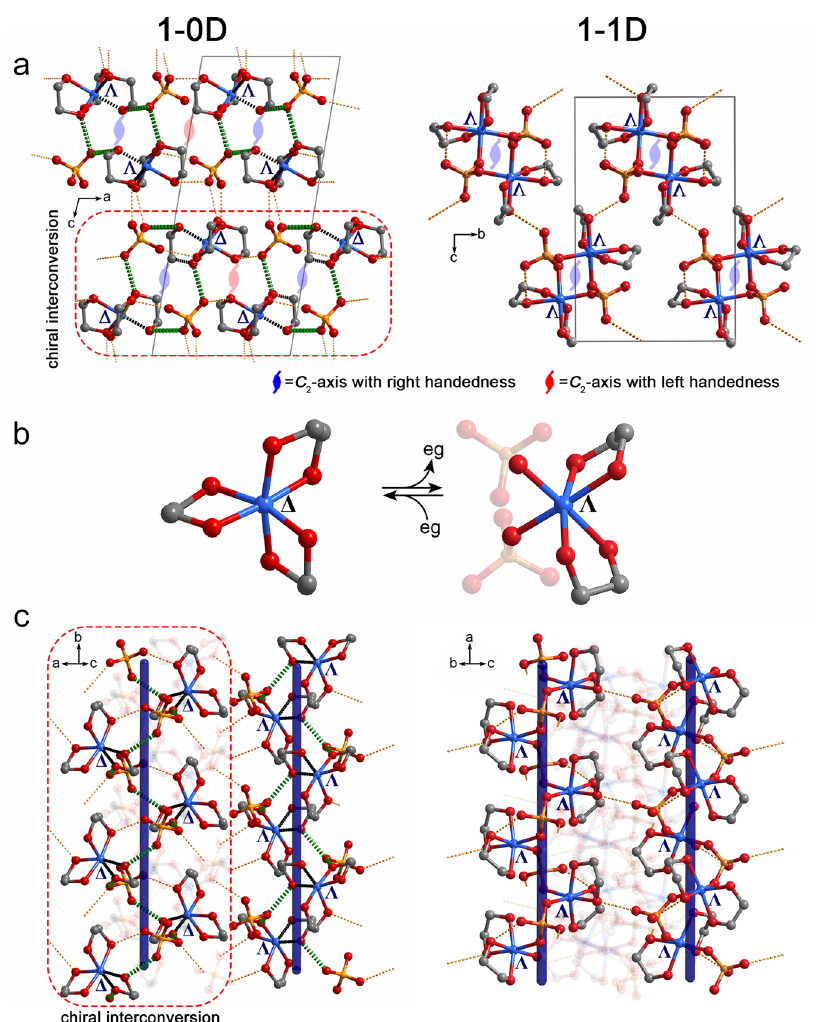
Fig. 4 Proposed mechanism for the SCSC transformation from 1-0D to 1-1D. a Contraction of the structure in the ac -plane. In the crystal of 1-0D , the hydrogen-bonded complex cations and anions form 1D helical architectures possessing both left and right handedness around the crystallographic C 2 axes (left panel), while the 1D helices in 1-1D exhibit identical handedness (right panel). b Chiral interconversion of complex cation with Δ con fi guration during the transformation from 1-0D to 1-1D with right handedness. c Contraction of structure along the crystallographic b axis. The green and yellow dashed lines denote the strong O – H···O hydrogen-bond interactions. The sulfates should substitute the eg ligands along the bold green dashed lines. Zn, blue; O, red; C, gray; S,